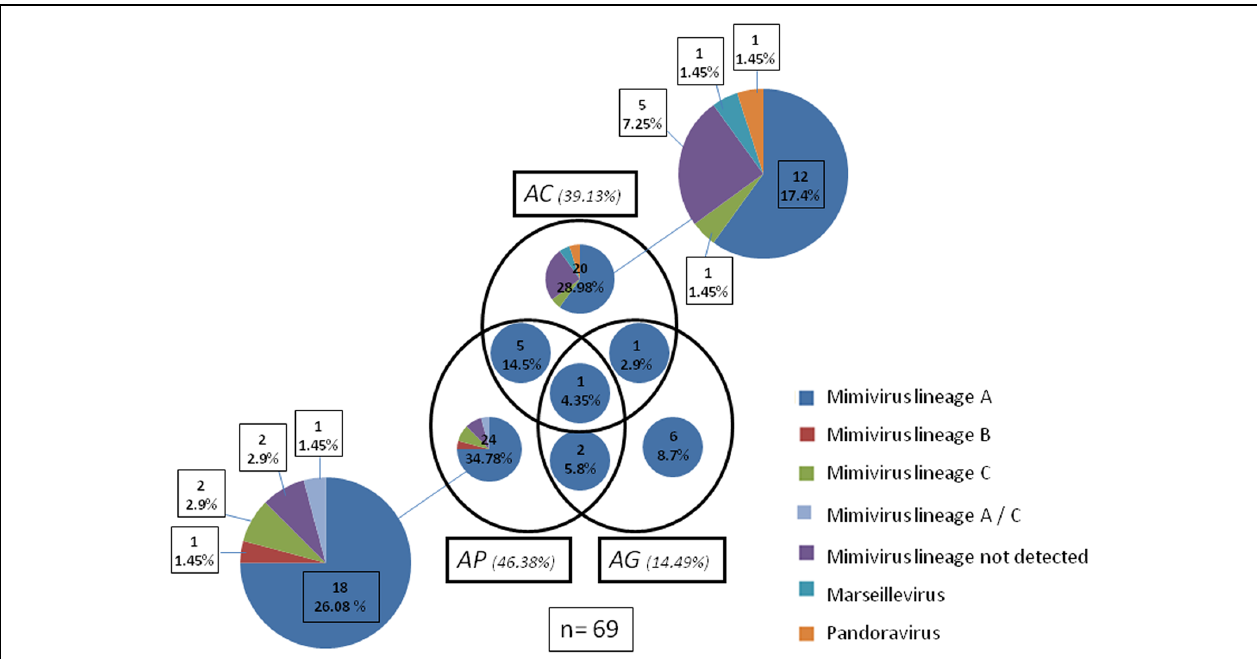
FIGURE 2 | Venn diagram, showing amoebas supports and isolated viruses. A total of 69 virus were isolated in the three different platform cellular AC Acanthamoeba polyphaga (AP) , Acanthamoeba griffinii (AG) are represented. Viruses come from the same species and lineages detected by PCR are represented with the same color. The interception of the circle show viruses isolates coming from the same environmental samples in different Acanthamoeba platform of isolation. All the small graphics inside the circle represents the species and lineage detected by PCR. Mimivirus that were not detected by PCR is also represented. The number and the percentual of viruses isolated are also expressed.